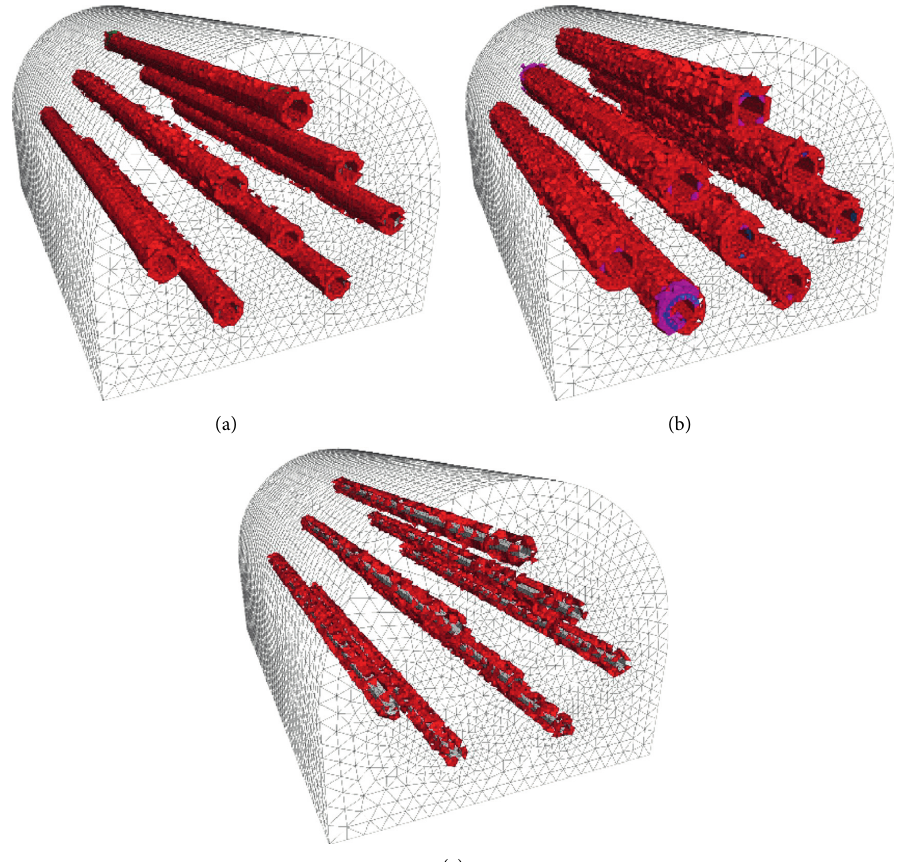
Figure 9: Plastic zones of pressure relief boreholes. (a) Φ 100mm. (b) Φ 200 mm. (c) Φ 300 mm.